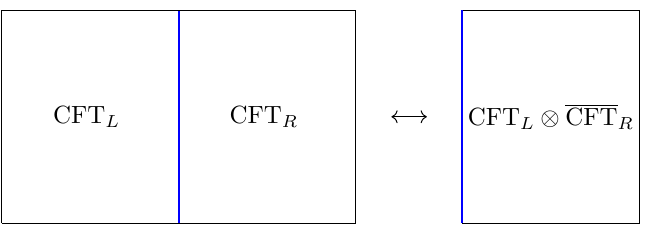
Figure 1 . The folding trick. CFT L and CFT R connected through the blue conformal interface can be viewed as a conformal boundary theory (BCFT) for the product CFT means that left- and right-movers of CFT